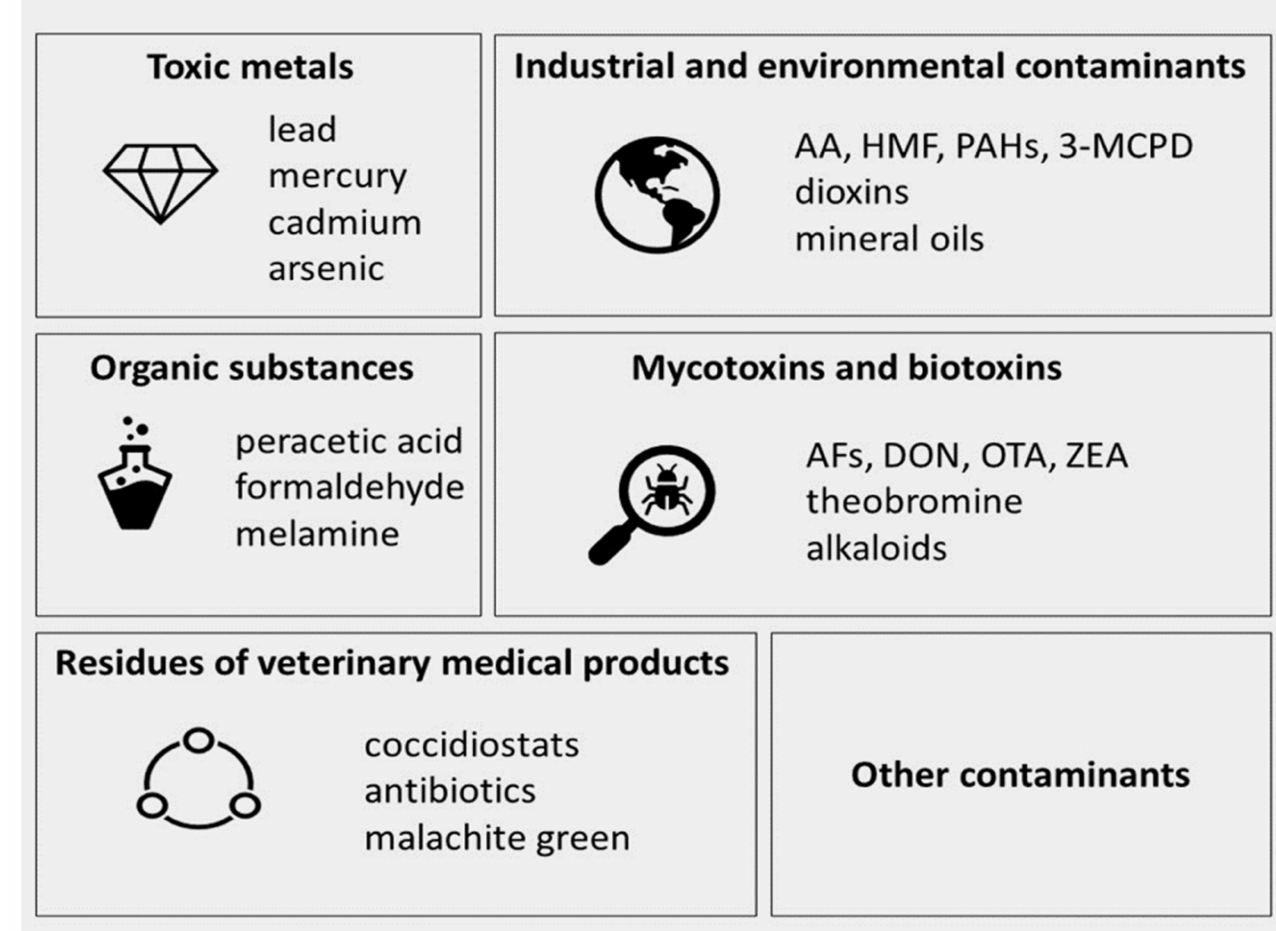
Figure 1. Classification of contaminants in the food chain on the basis of the European Food Safety Authority